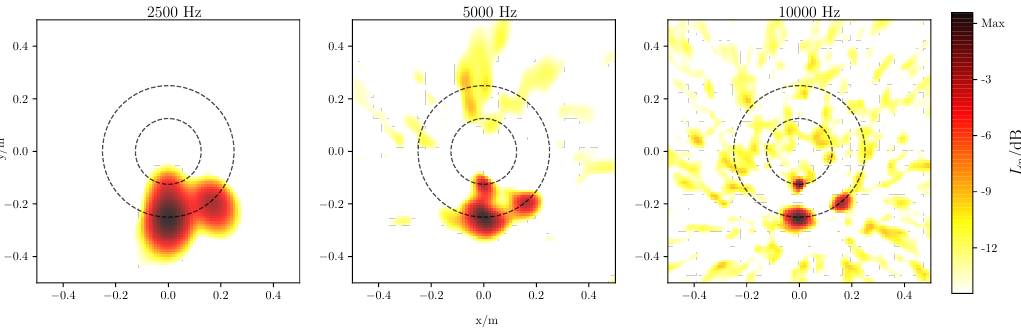
Figure 6. Octave band source maps for 2.5, 5 and 10 kHz obtained with the spiral array and RBF interpolation between the